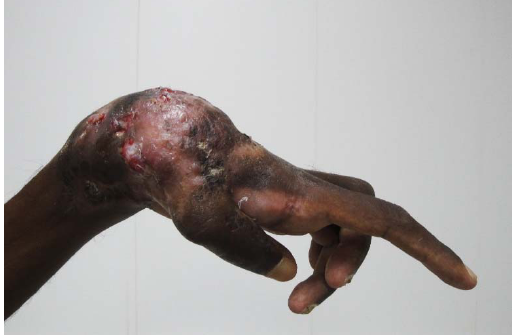
Figure 8. Hand eumycetoma with massive deformity.